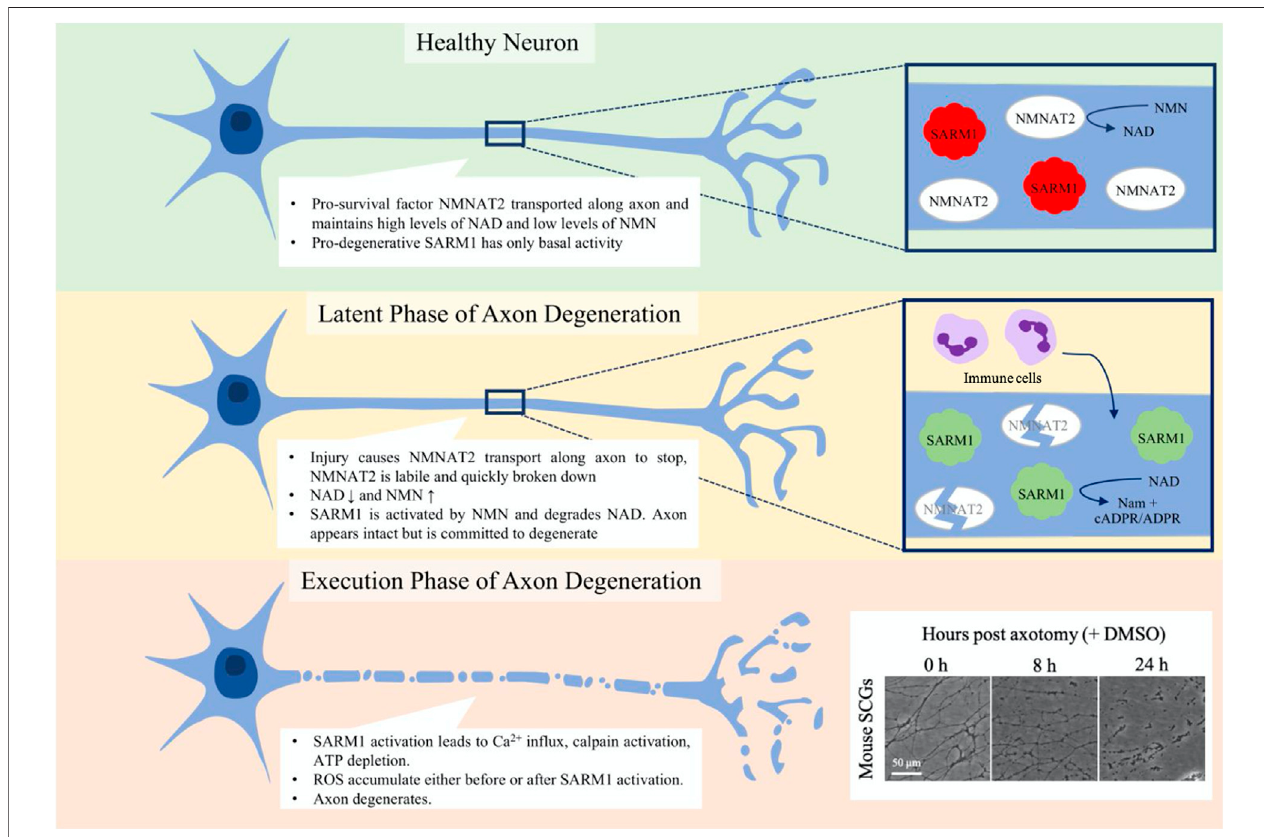
FIGURE 2 | Phases of programmed axon degeneration. Programmed axon degeneration is split into two main phases, the latent phase, where the axons are morphologically normal but are committed to degeneration, and the execution phase, where the axon undergoes gross swelling and granulation as it breaks down. In healthyneurons,NMNAT2pro-survivalfactorconvertsNMNtoNAD,maintainingNADandNMNlevelsthatkeepSARM1pro-degenerativefactorinactive.Afterinjury,in thelatentphaseNMNAT2startstobebrokendownandcannotbetransportedalongtheaxon.NADlevelsthuslowerandNMNlevelsrise,leadingtotheactivation of SARM1. Immune cells are seen to enter the nerve at this stage. After up to 36 h, the axons progress to the execution phase, where Ca 2+ levels increase, calpains are activated and the axon breaks down. Mouse superior cervical ganglia (SCGs) are often used as an assay for axon degeneration. The box on the bottom corner shows axondegenerationprogressingover24 hpost-axotomy.At8 haxonsarecommittedtodegenerateandsomehavestartedvisiblybreakingdown.By24 h,allaxonsare degenerating and much of what is seen is axon debris.